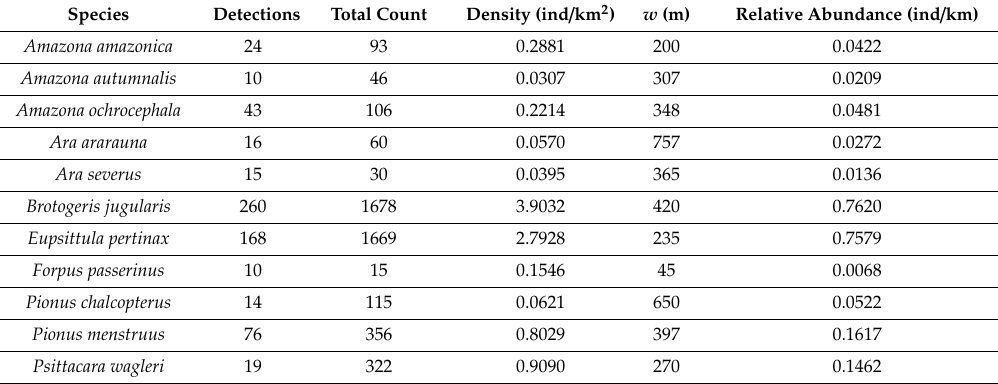
Figure 2. Relationship between detectability-corrected estimates of density and relative abundances of 11 parrot species. The regression line (solid) and 95% confidence interval (dashed lines) are plotted. Table 1. Detectability-corrected estimates of density (individuals / km 2 ) obtained through distance sampling and relative abundances (individuals / km) for parrot species with at least 10 visual detections (i.e., sightings of individuals or groups of individuals). Total count refers to the total number of individuals observed during surveys. w indicates the maximum perpendicular detection distance from the survey line for each